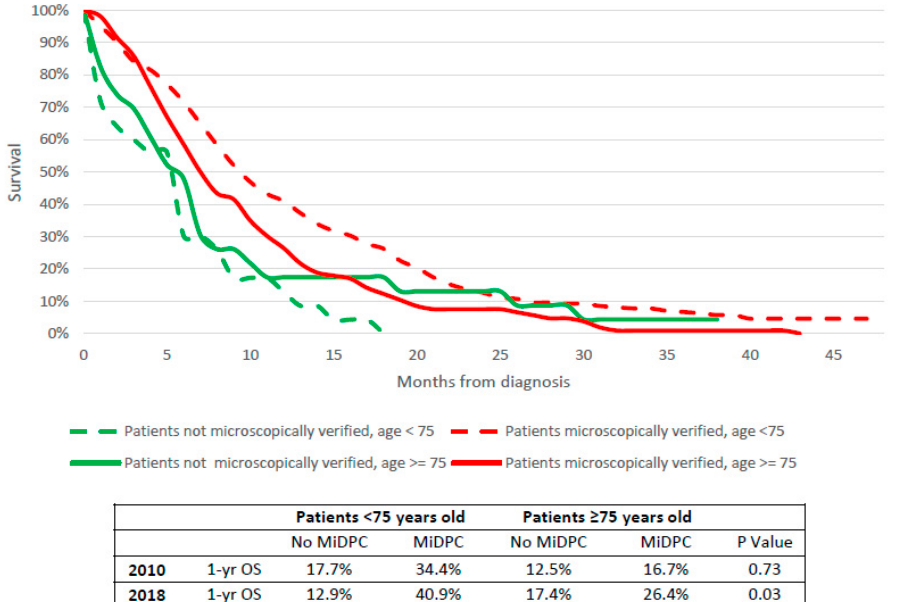
Figure 7. Survival of Stage III-IV pancreatic cancer patients of the Veneto region population who underwent chemotherapy alone according to diagnostic confirmation and age.